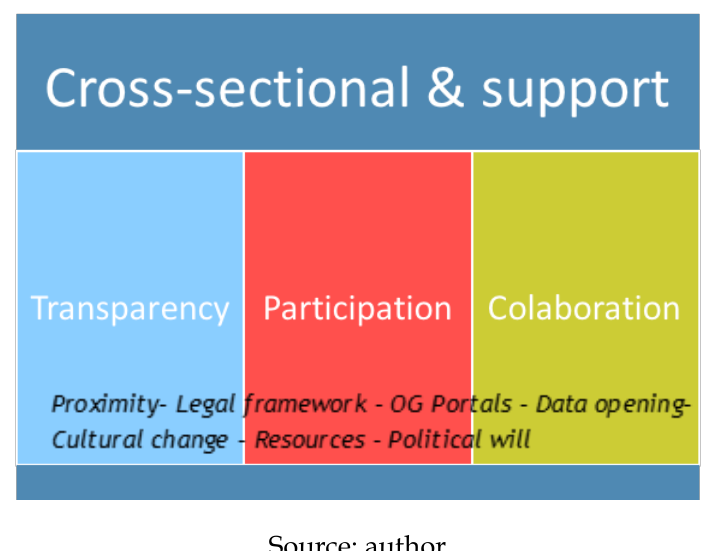
Figure 2 "Model of Local Open Government for Calle